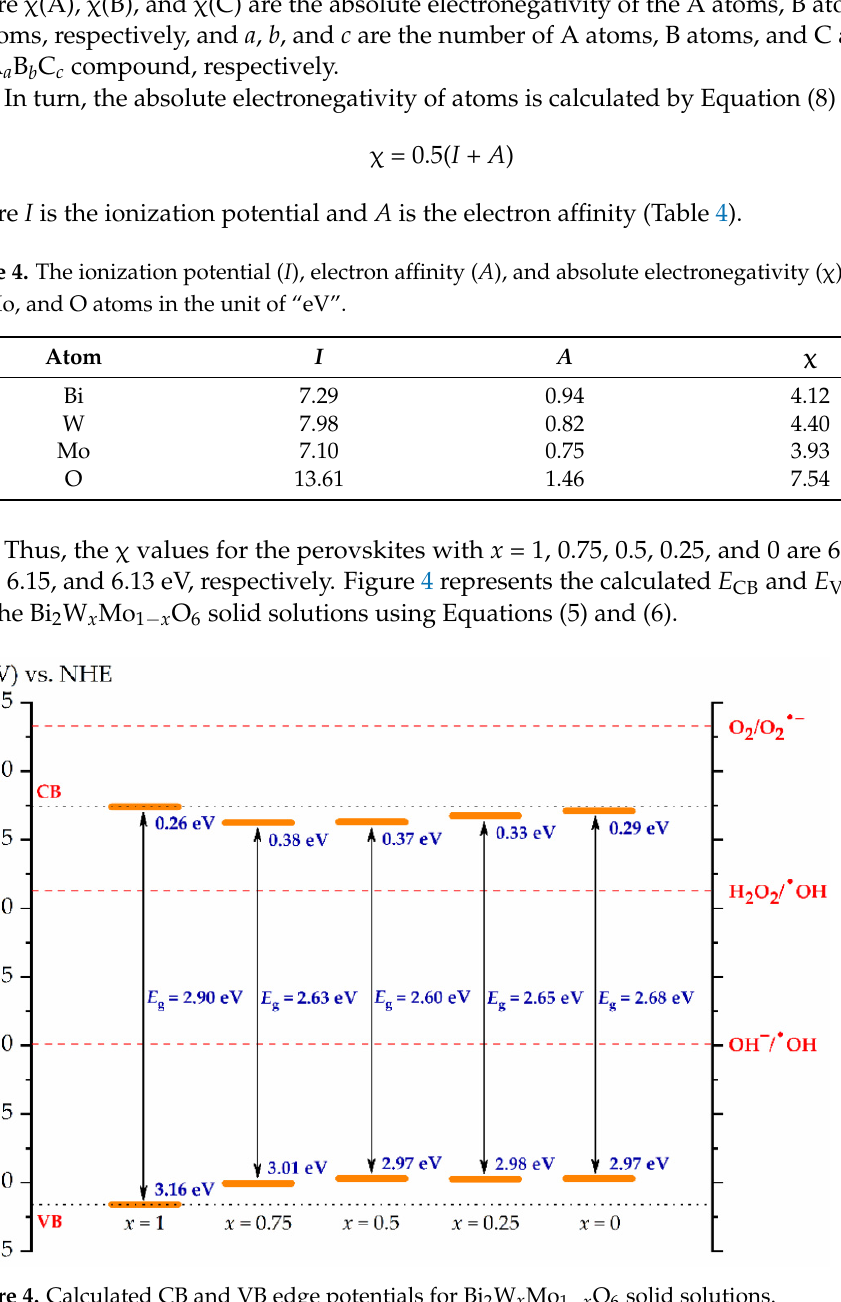
Figure 4. Calculated CB and VB edge potentials for Bi 2 W x Mo 1 − x O 6 solid solutions.